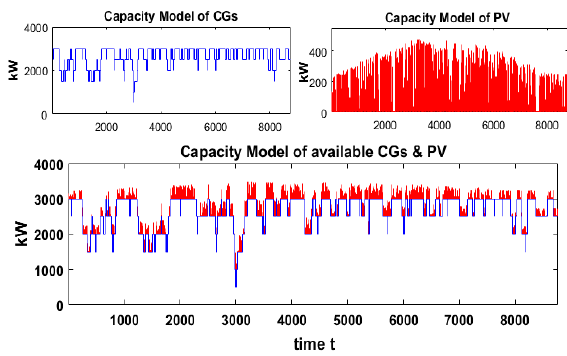
Figure 10. Capacity Models of CGs and PV.